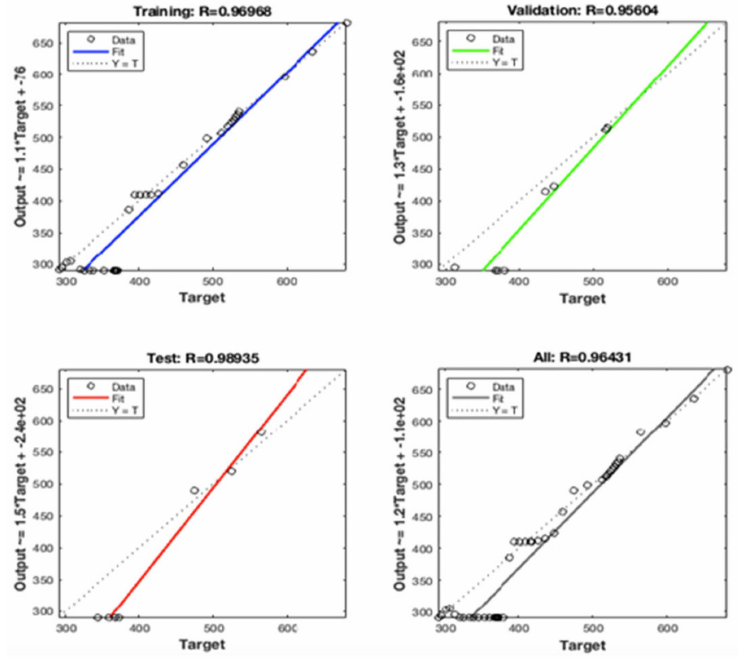
Figure 3. Model linear fitting in training and testing for model